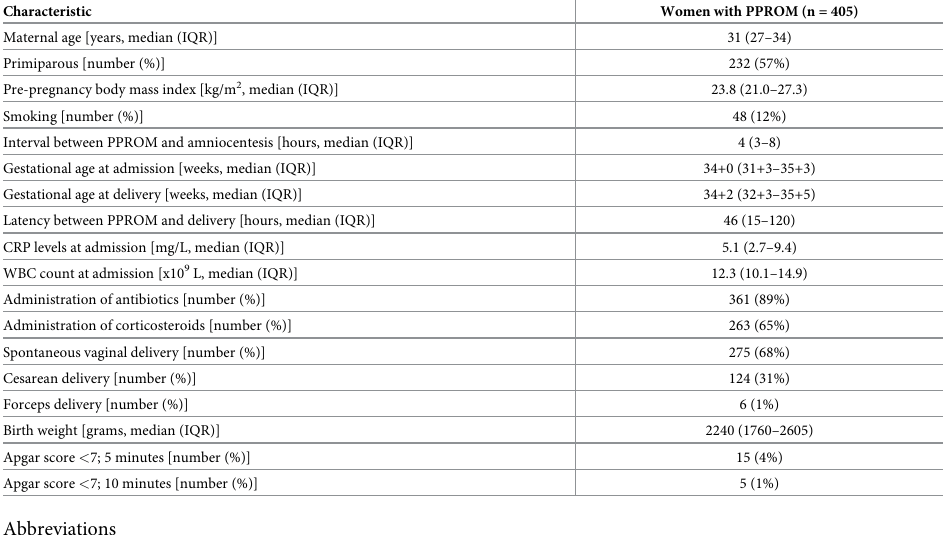
Table 1. Maternal and clinical characteristics of pregnancies complicated by preterm prelabor rupture of the membranes.